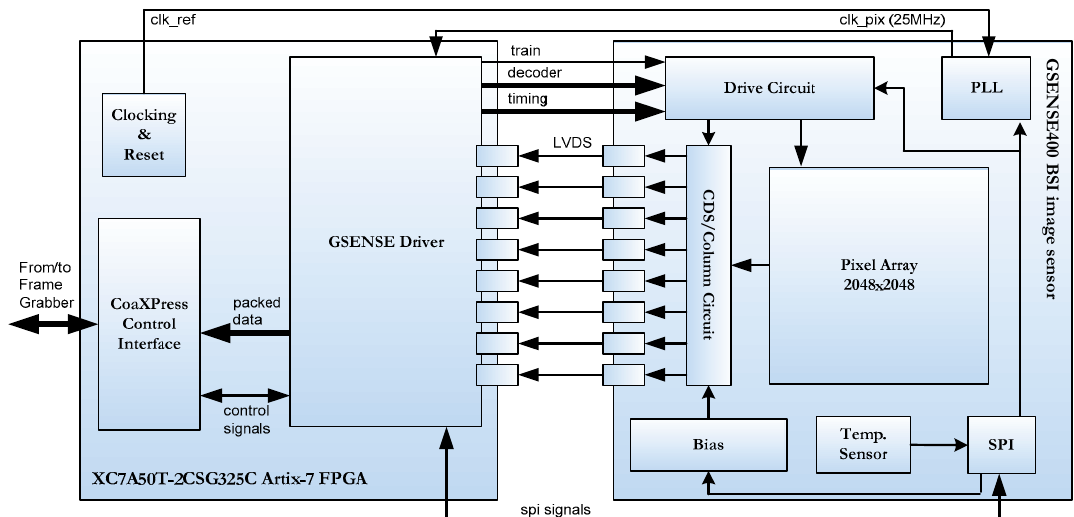
Figure 1. Diagram of the connection system between the image sensor and the FPGA device in the TuMag camera.